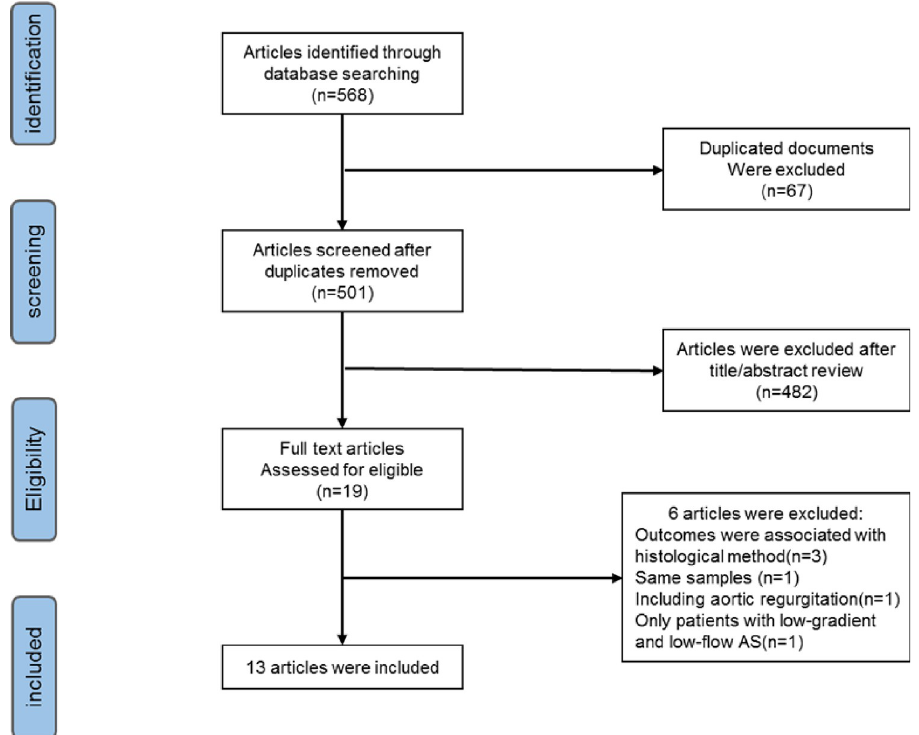
Fig 1. Flow diagram of the literature search